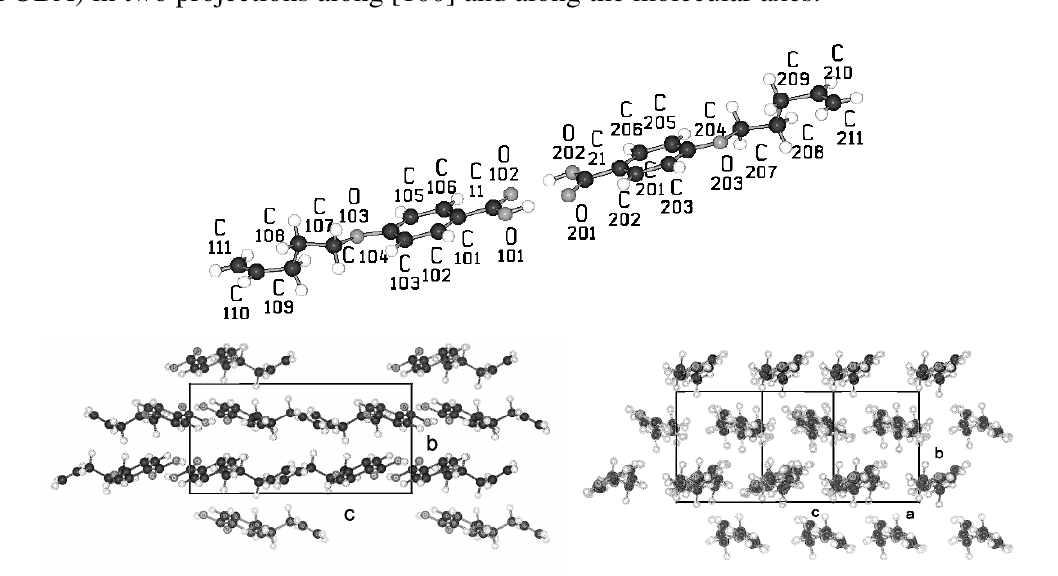
of 4-(pent-4-enoxy)benzoic acid 1